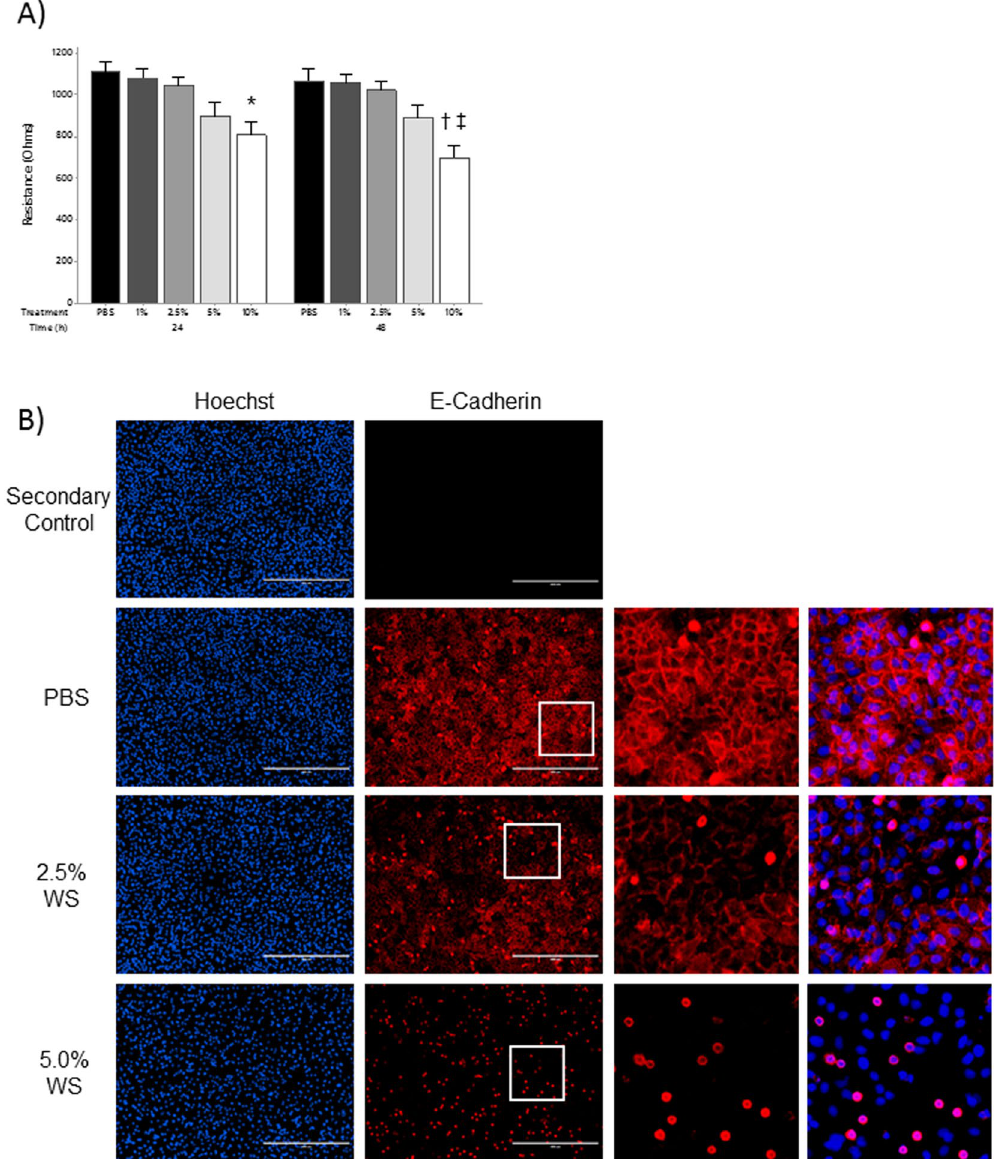
Figure 4. Wood Smoke and Epithelial Barrier Function. ( A ) Epithelial barrier function was evaluated at 24 and 48 hours by ECIS. Resistance at 4 kHz was used as a measure of barrier function. * P < 0 . 05 vs. 24 h PBS, 1% WS; † P < 0 . 001 vs. 24 h PBS; ‡ P < 0 . 01 vs. 24 h 1% WS, 2.5% WS and 48 h PBS, 1% WS 2.5% WS; n = 3. Statistical differences were determined using a two-way ANOVA and a Tukey’s post-hoc test. Data presented as mean ± se. ( B ) Cell-cell contacts were assessed 24 hours post-WS exposure via staining for the cell adhesion marker E-cadherin. Immunofluorescent staining demonstrated a dose dependent loss of typical cobblestone E-cadherin staining and accumulation of intense intracellular staining. Cell coverage was demonstrated by staining nuclei with Hoechst (scale bar = 400 μ m; n =